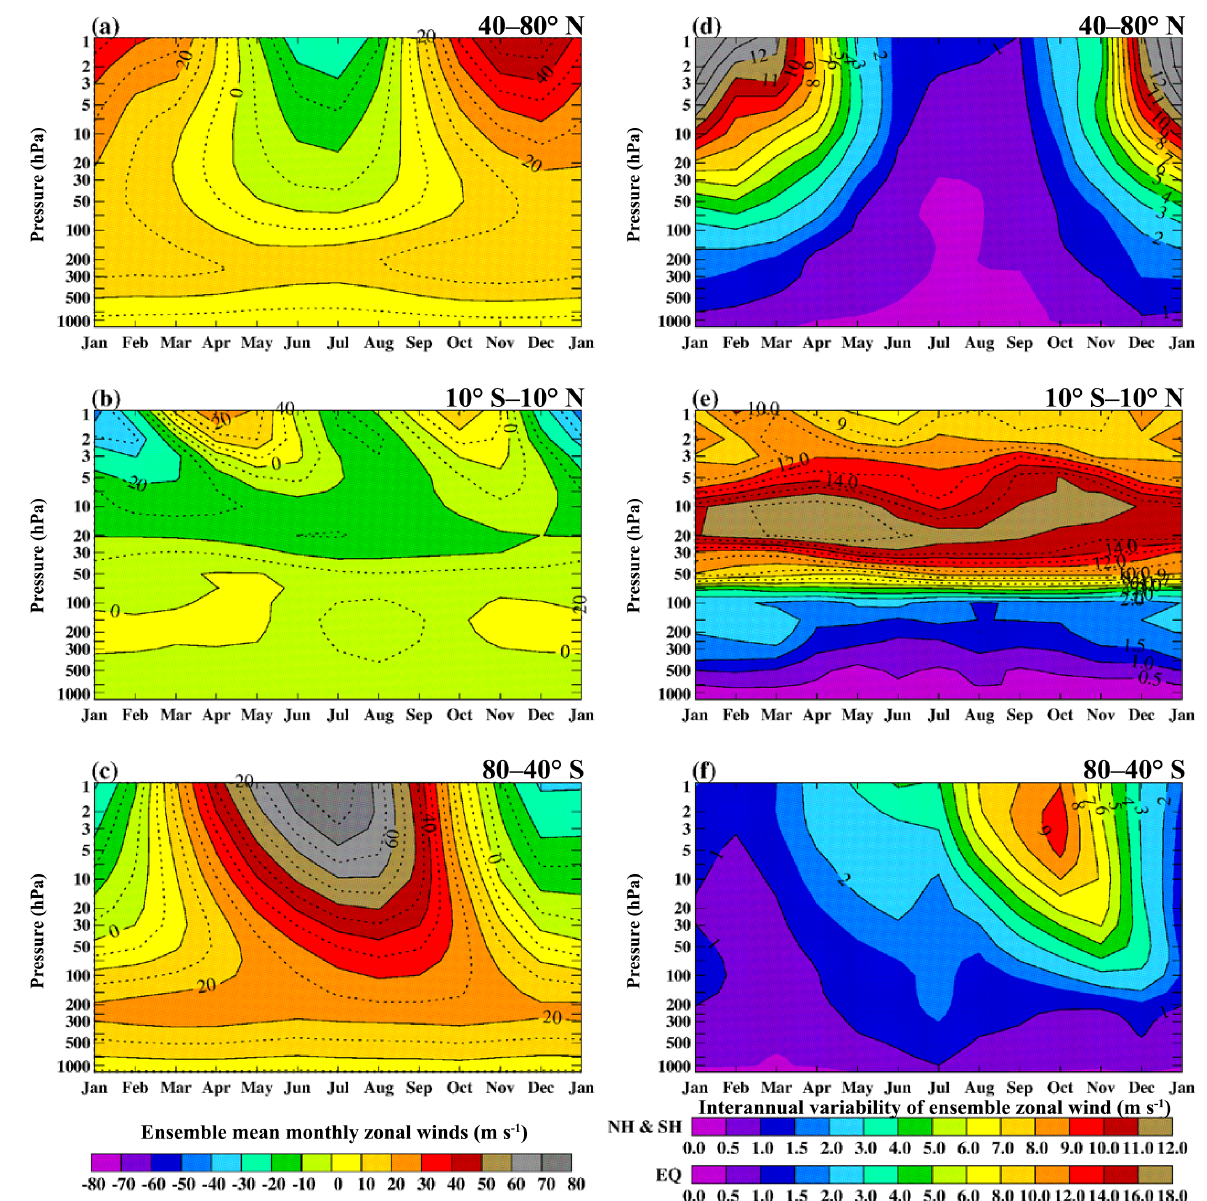
Figure 3. Annual variation in the REM zonal wind monthly means (ms − 1 ) and their SD (ms − 1 ) in three different zonal regions: 40– 80 ◦ N (a, b) , 10 ◦ S–10 ◦ N (c, d) , and 80–40 ◦ S (e, f)